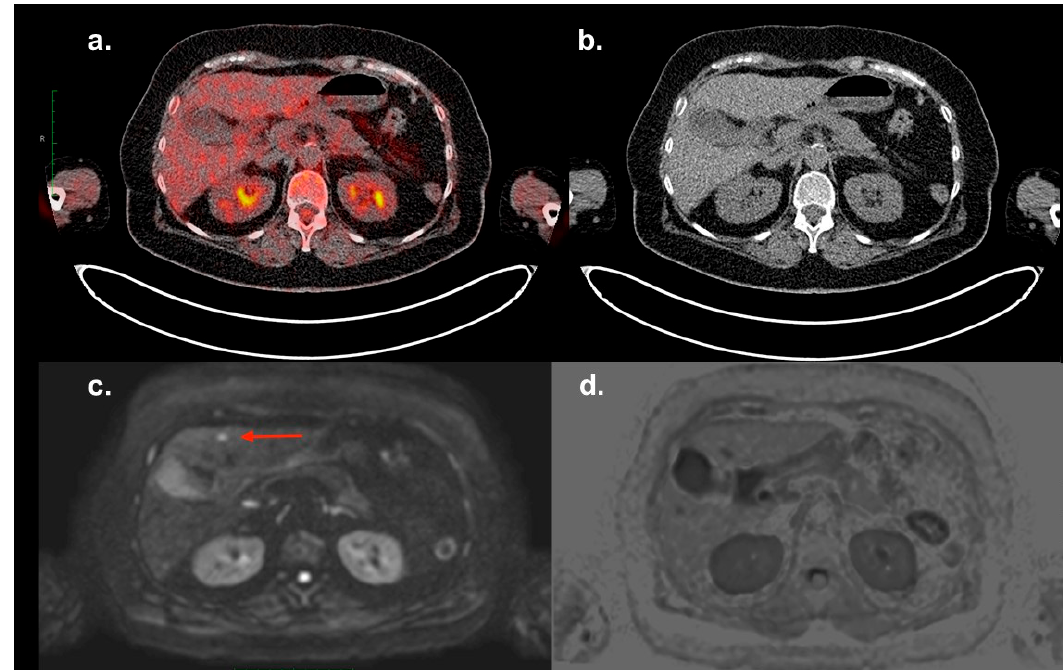
Figure 2. A patient with MM (Typ IgG lambda, Stage IA according to the Durie–Salmon staging system, ISS I) underwent an 18F-FDG PET/CT and a routine whole-body MRI investigation after radiation therapy of an extensive plasma cell infiltration in the sternum and three courses of induction therapy. No signs of further focal lesions were illustrated in previous CT and MRI investigations. A contrast-enhanced CT-scan was not performed in this case. The subsequent 18F-FDG PET/CT ( a , b )